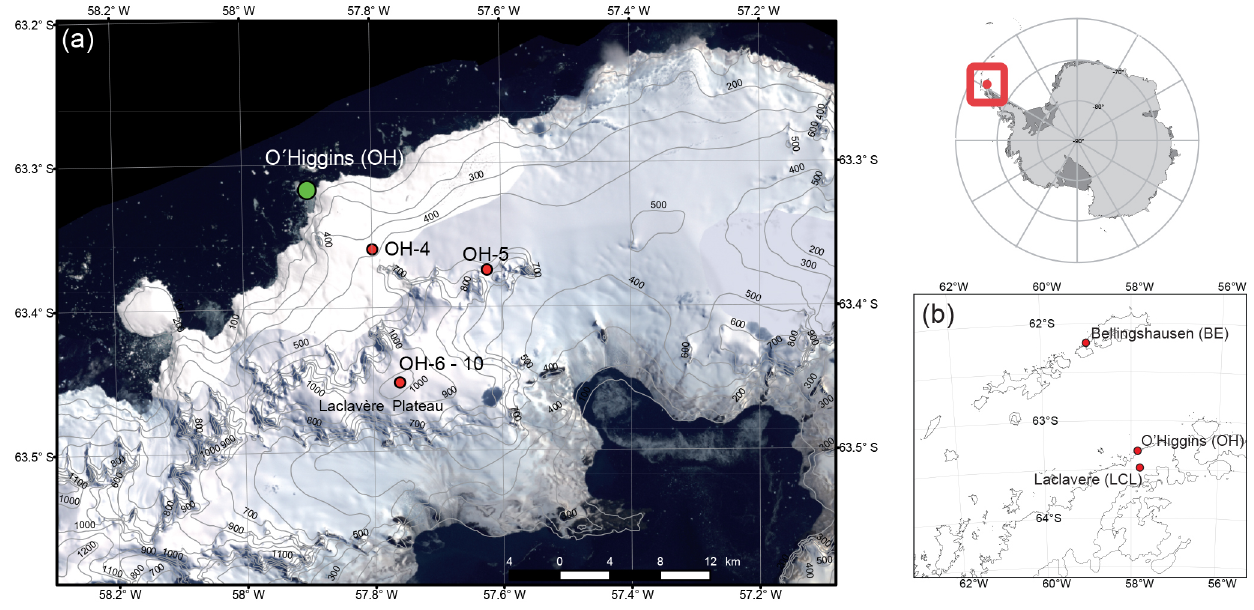
Figure 1. Study area and location of the firn cores presented in this work. (a) Detail of the study zone: the green point shows the Chilean Station O’Higgins (OH) on the west coast of the Antarctic Peninsula. Firn cores retrieved between 2008 and 2015 are shown by red dots. (b) Location of O’Higgins and Bellingshausen Station and Laclavère Plateau, which are mentioned throughout the text. Satellite image (Landsat ETM + ) and digital elevation model (RADARSAT) available from the Landsat Image Mosaic of Antarctica (LIMA) (http://lima. usgs.gov/). Table 1. Statistical summary of the geographical location and water stable isotope composition of all firn cores examined in this work. OH-4 and OH-5 correspond to cores retrieved on the west side of the AP, whereas OH-6, OH-9 and OH-10 were retrieved at LCL on the east-west divide. All cores were analyzed in a 5cm resolution. Core OH-4 OH-5 Altitude (m